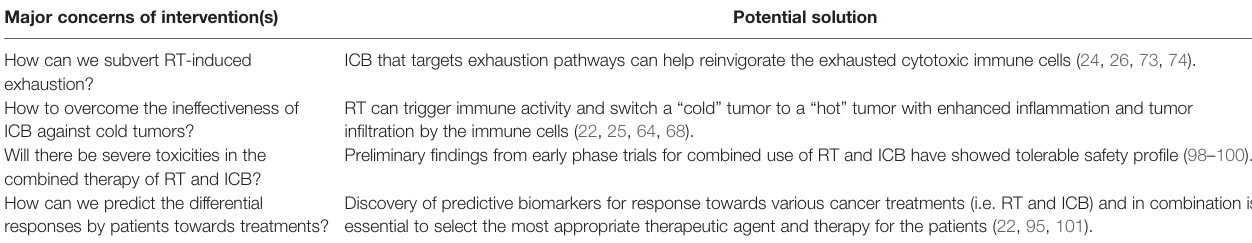
TABLE 1 | Major considerations for the combination of RT and